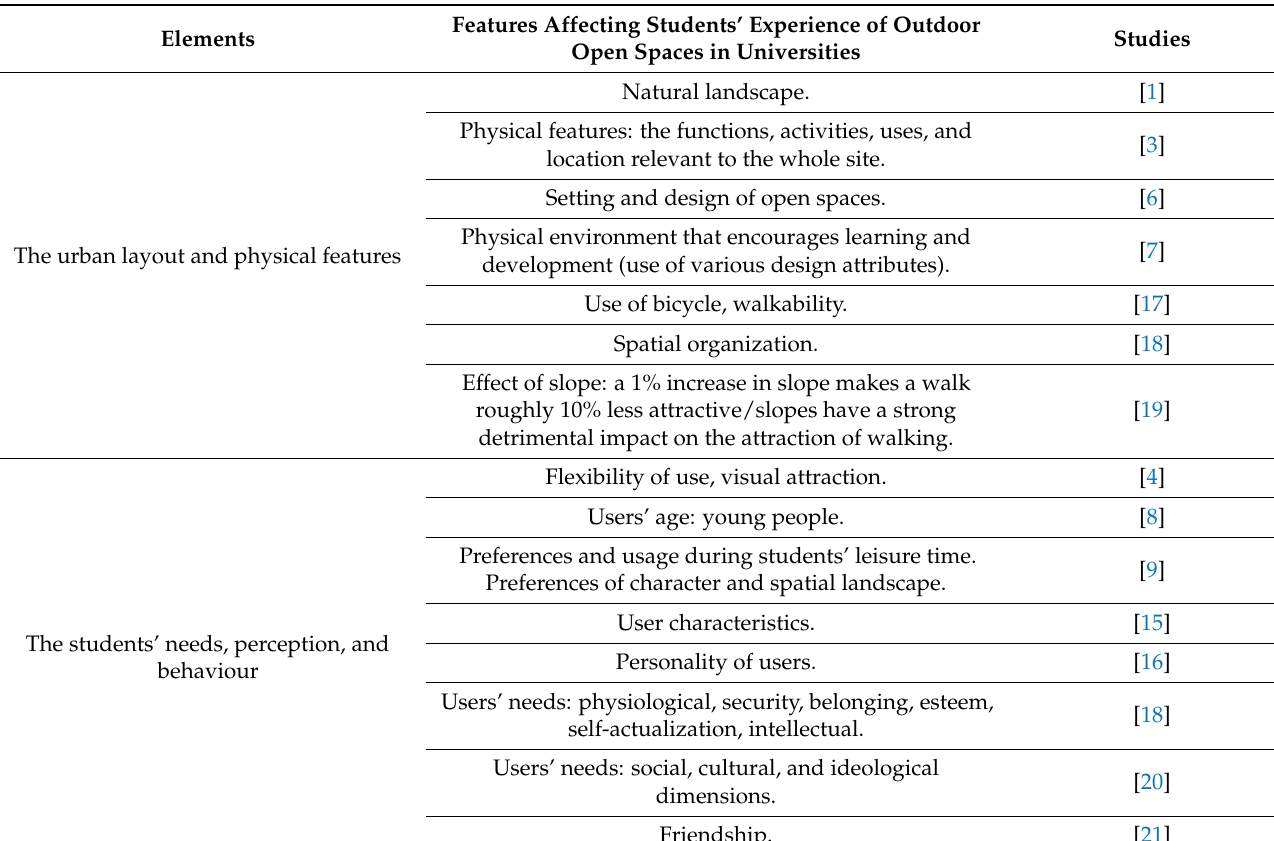
Table 1. Literature exploring the key elements that influence students’ experiences of outdoor open spaces.